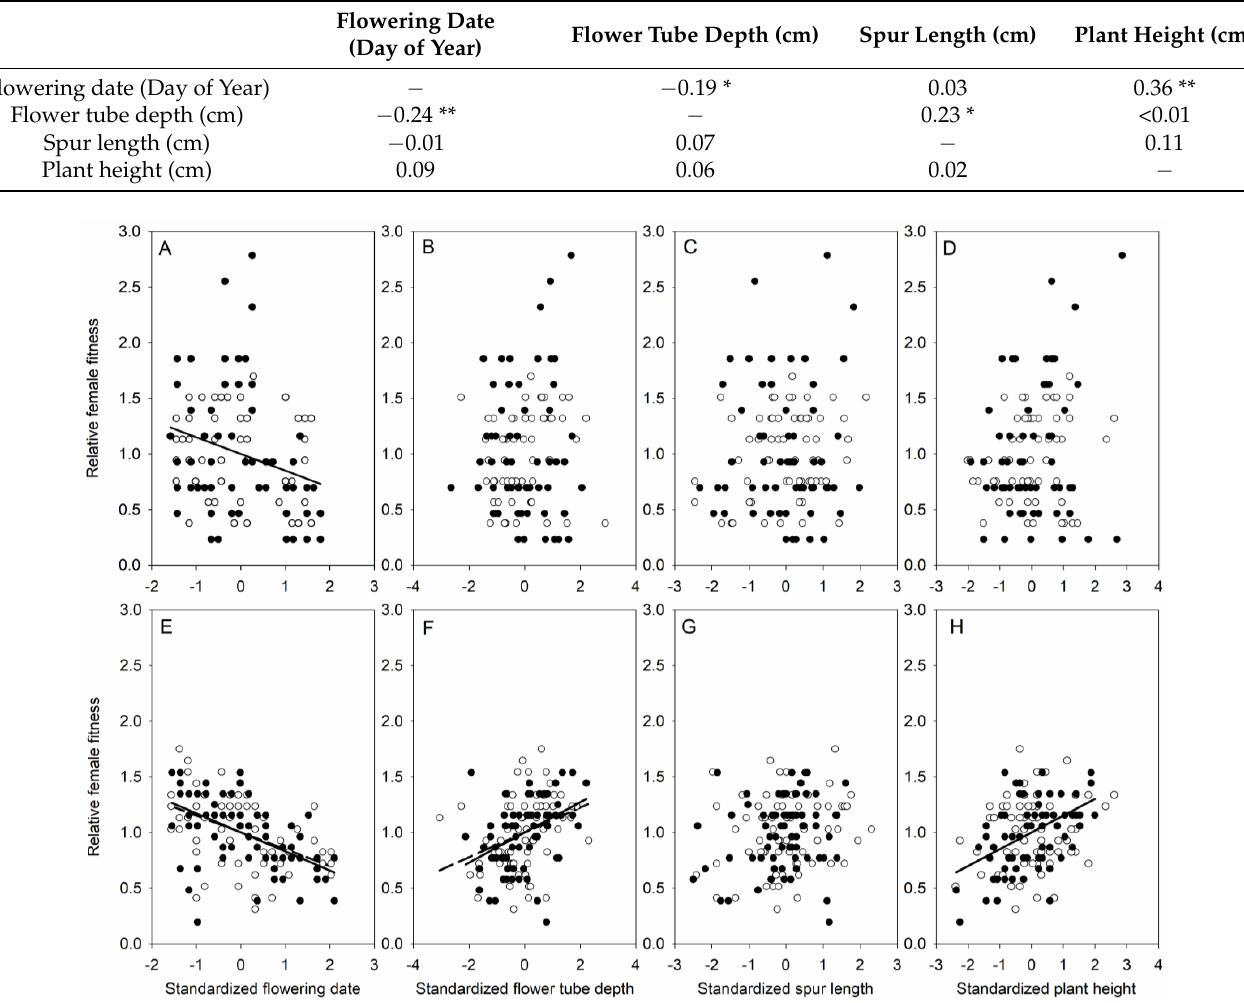
Figure 3. Linear selection differentials for the flowering date ( A , E ), flower tube depth ( B , F ), spur length ( C , G ), and plant height ( D , H ) in the control (filled circles and line, p < 0.05) and netted (open circles and dotted line, p < 0.05) flowers from two populations with low ( A – D ) and high ( E – H ) selfing rates. Table 3. Phenotypic linear selection differentials ( ± SE) for the flowering date, flower tube depth, spur length, and plant height via female fitness in netted and control flowers from two Halenia elliptica populations with different selfing rates. Significant selection differentials are shown in